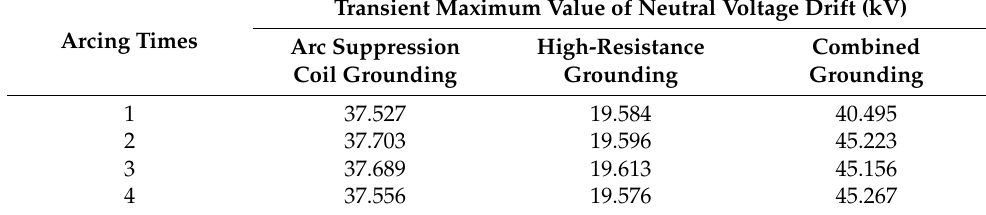
Table 3. Neutral point transient voltage drift under multiple arcing.